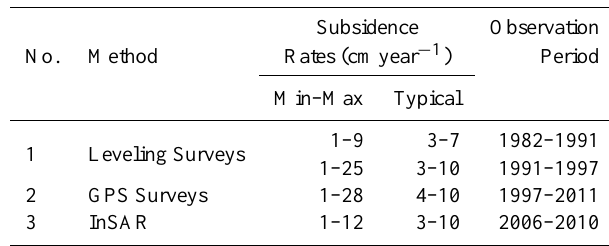
Table 1. Observed land subsidence rates in Jakarta; after Abidin et al. (2001, 2011, 2013).